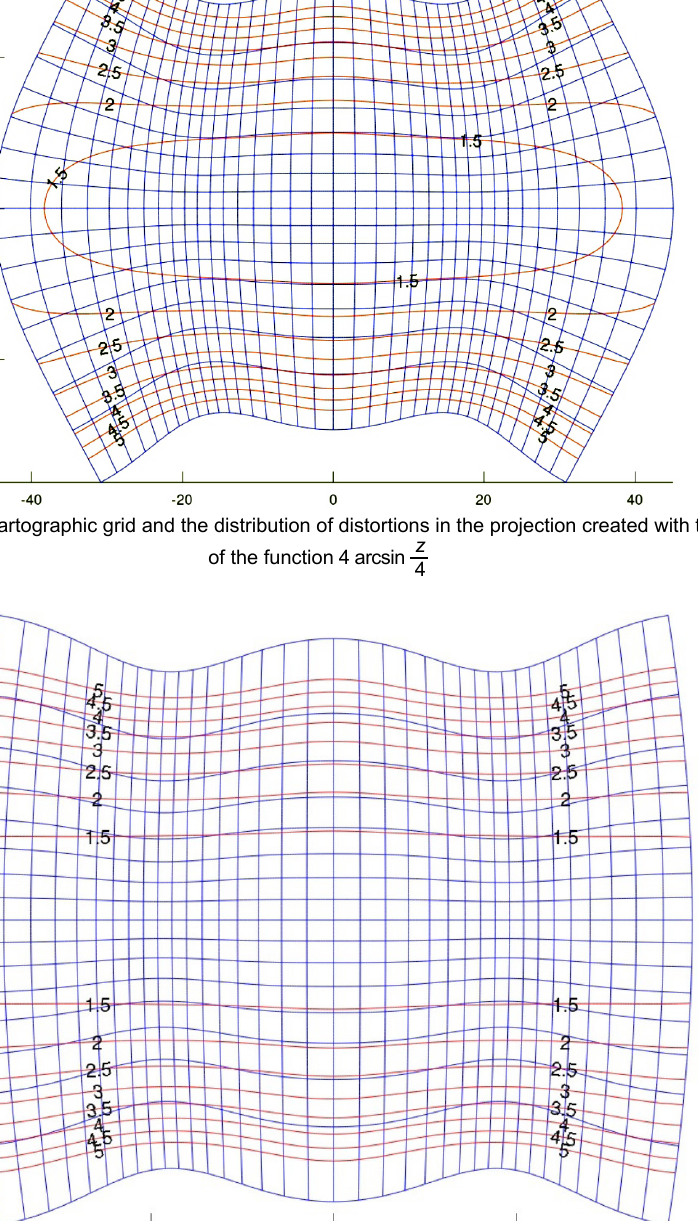
Fig. 19. The cartographic grid and the distribution of distortions in the projection created with the use z of the function 8 arcsin